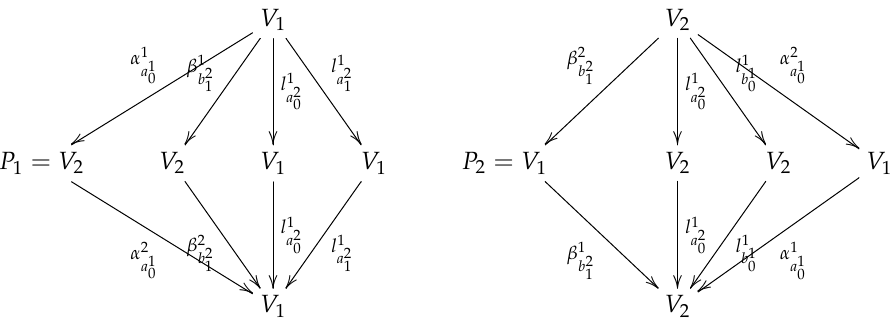
Figure 5. Indecomposable projective Λ Γ 2 -modules. Note that the number of composition series equals the number of non-truncated vertices in the corresponding polygon.